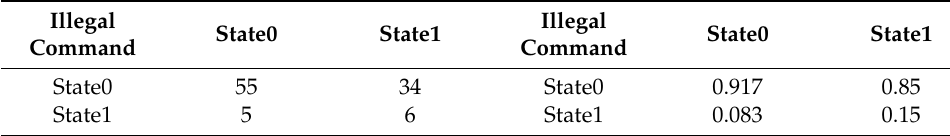
Table 7. Perceptual errors frequency statistics and conditional probability table.